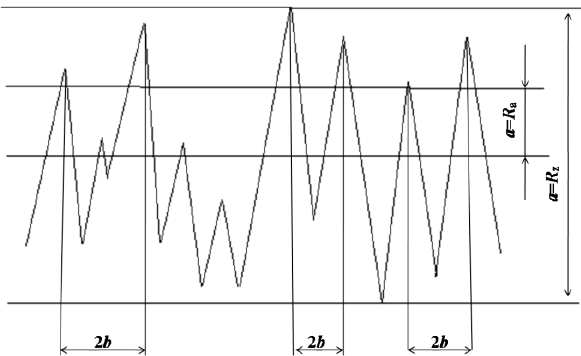
Figure 13. Schematic diagram of depth and spacing of surface roughness.